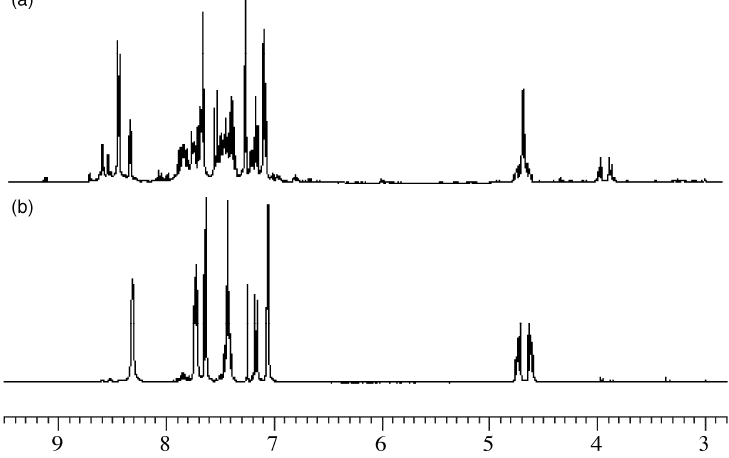
Figure 2. 1 H-NMR spectra in CDCl 3 for ( a ) 1a after irradiation for 24 h; and ( b ) 1a after irradiation in the presence of 3 eq. of HCl and successive neutralization.